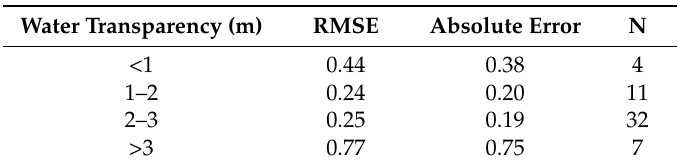
Figure 13. Satellite-derived water transparency map of the south basin of Lake Biwa (2013-2016): ( a ) October 2013, ( b ) September 2014, ( c ) September 2015, and ( d ) September 2016. Table 3. Accuracy assessment of satellite-derived water transparency with in situ data (October 2013), for the south basin of Lake